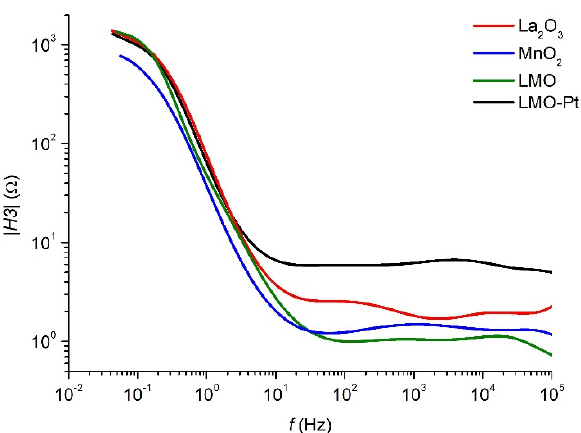
Figure 6. Third harmonics for ORR at La 2 O 3 , MnO 2 , LMO, and LMO-Pt in O 2 -saturated 0.10 M KOH gained by GEIS at OCP with current amplitude of 0.10 mA.